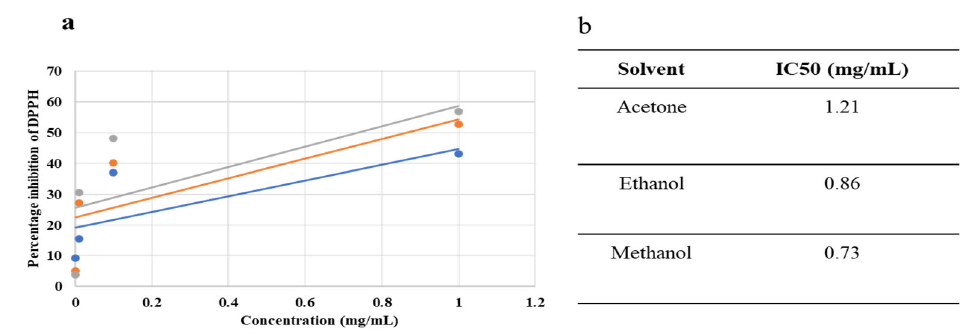
Table 2. Free radical scavenging activity of Coronopus didymus using DPPH assay (mean ± standard deviation).